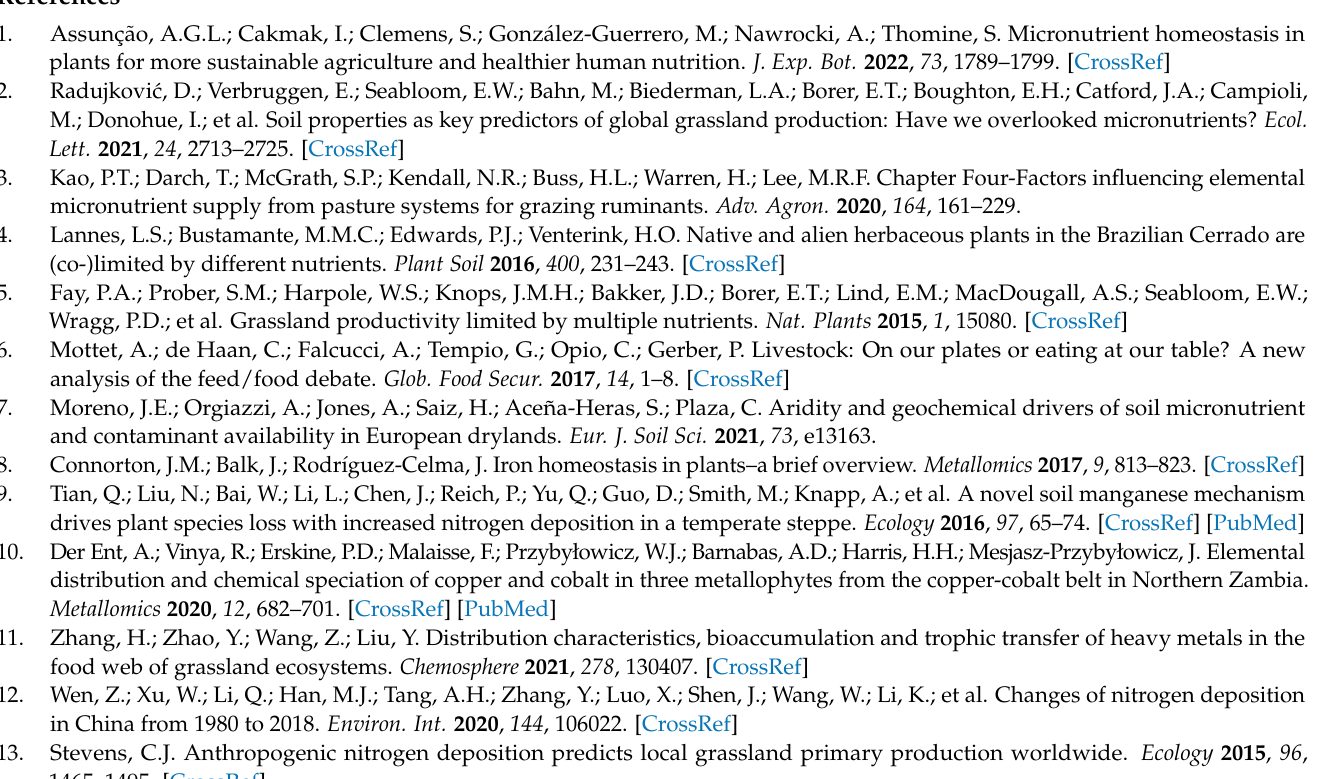
Figure S2: Effects of N addition on the pools (dry biomass × contents) of six micronutrients with unmowing and mowing treatments in aboveground plant parts; Figure S3: Effects of N addition on the contents of six micronutrients with unmowing treatments in litter; Figure S4: Effects of N addition on the pools of six micronutrients with unmowing and mowing treatments in belowground root; Figure S5: Relationships of soil total Fe, Mn, Cu, Zu, Co, and Mo with their corresponding contents inaboveground plants (purple points), litter (green triangles) and roots (orange